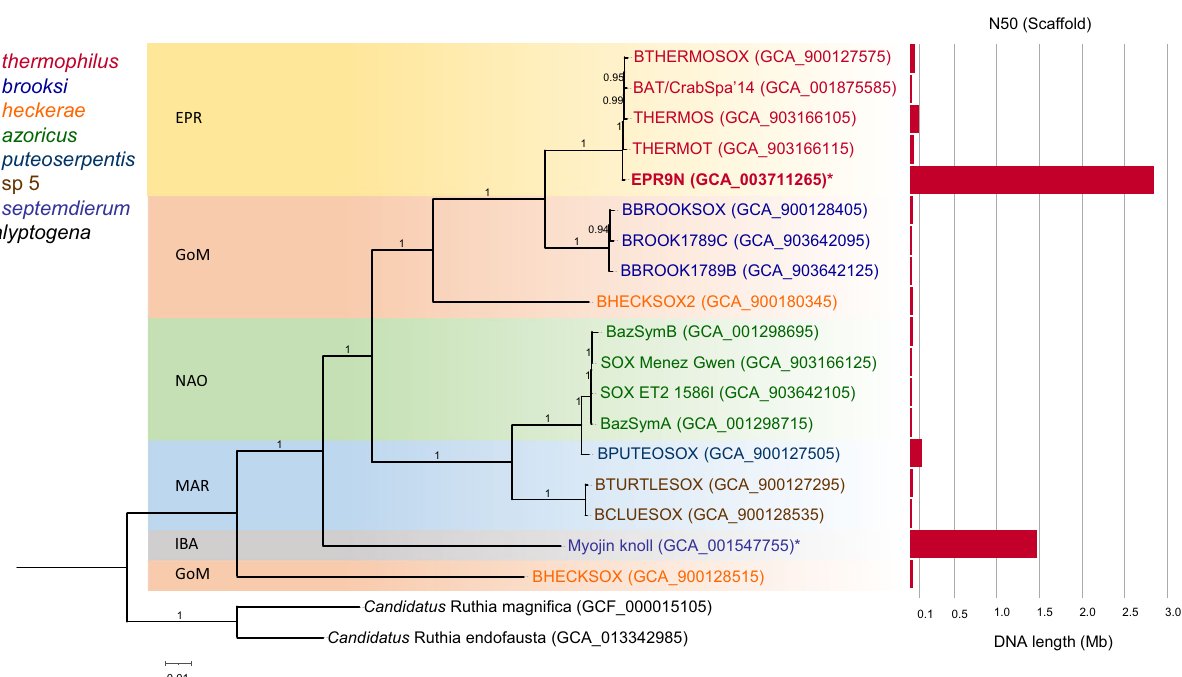
Figure 1. Maximum likelihood phylogeny of single-copy-orthologous genes for deep-sea mussels’ thiotrophic gill endosymbionts. Deep-sea clam symbiont genomes of Candidatus Ruthia magnifica and Candidatus Ruthia endofausta were used as outgroup. Legends represent the host Bathymodiolus species and outgroup Calyptogena . Location of mussel symbionts are presented in background-colored boxes. EPR East Pacific Rise, GoM Gulf of Mexico, NAO North Atlantic Ocean, MAR Mid Atlantic Ridge, IBA Izu-Bonin Arc, Japan. Assembly ID of each symbiont genome is presented in parentheses. The bar chart shows each symbiont genome assembly’s N50 (Scaffold) values. *Represent the complete and circular